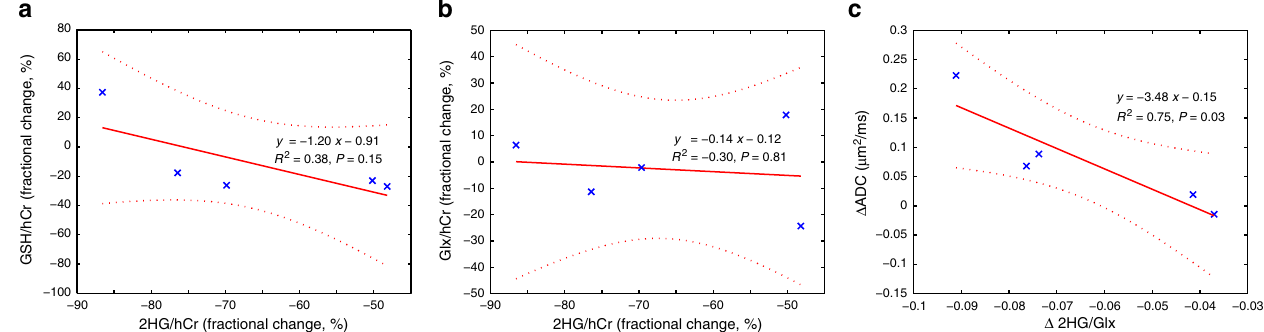
Fig. 4 Relation between the treatment induced changes of 2HG and other metabolic and imaging biomarkers. Linear model fi tting has been employed to investigate the relationship between the changes: a 2HG and GSH; b 2HG and Glx; c ratio of 2HG/Glx and ADC. A signi fi cant inverse correlation was found between changes of 2HG/Glx ratio and changes of ADC after 1 week of treatment with